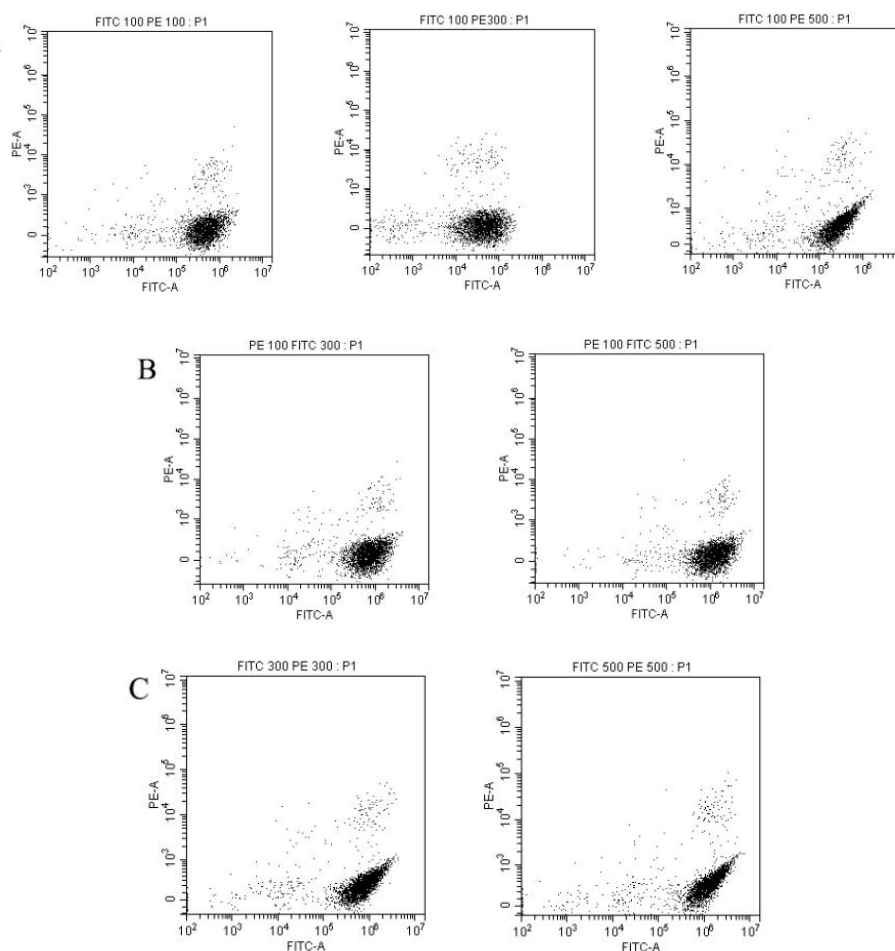
Figure 8. Different combinations of gain settings of FITC and PE channels. ( A ) FITC, 100; PE, 100, 300, and 500; ( B ) PE 100; FITC, 300, 500; and ( C ) FITC, 300, 500; PE 300, 500.